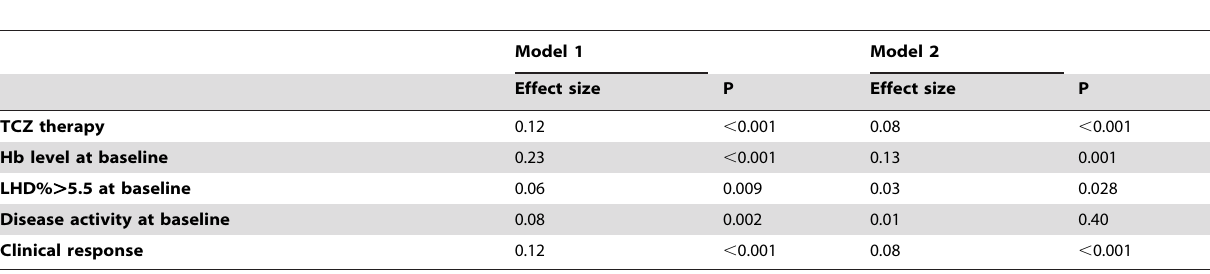
Table 3. Effect of TCZ therapy and other confounding factors for the increase of Hb